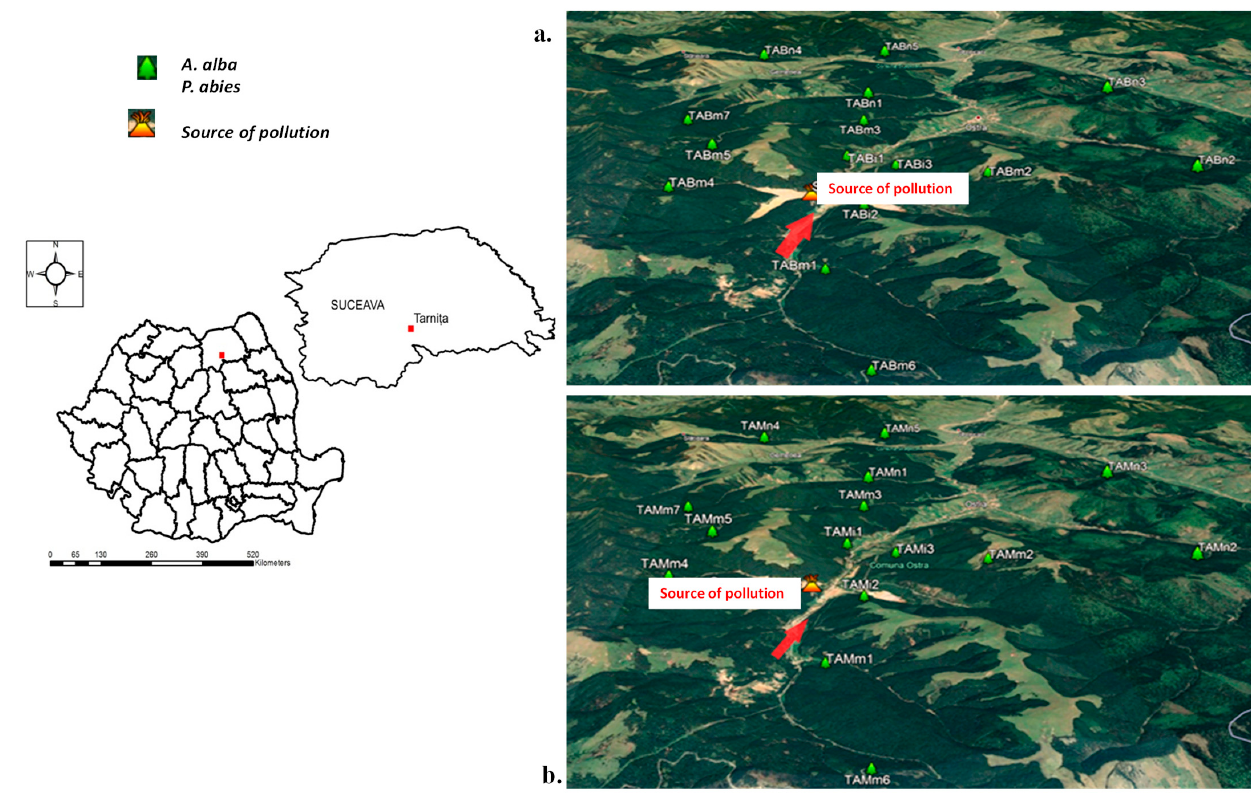
Figure 1. Study location: ( a ) Silver fir from Tarni ț a region; ( b ) Norway spruce from Tarni ț a region (the red arrow indicates the source of pollution and the predominant direction of airmasses in the area is NE–SW, according to the valley orienta ‐ tion).